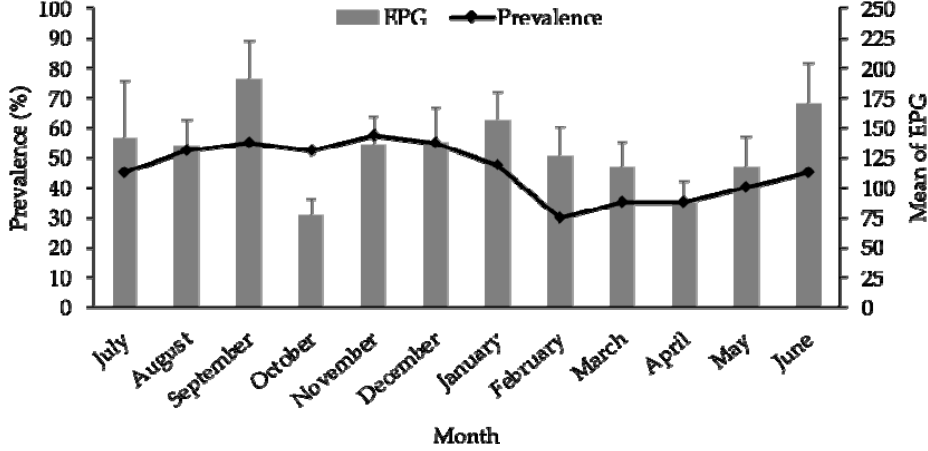
Figure 3. Monthly trend of cattle fascioliasis in Kelantan from July 2018 to June 2019.